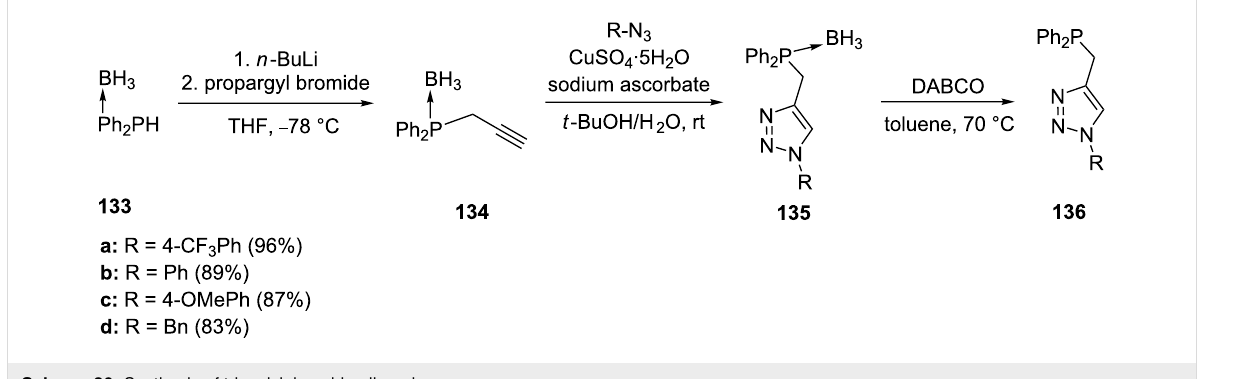
Scheme 26: Synthesis of triazolylphosphine